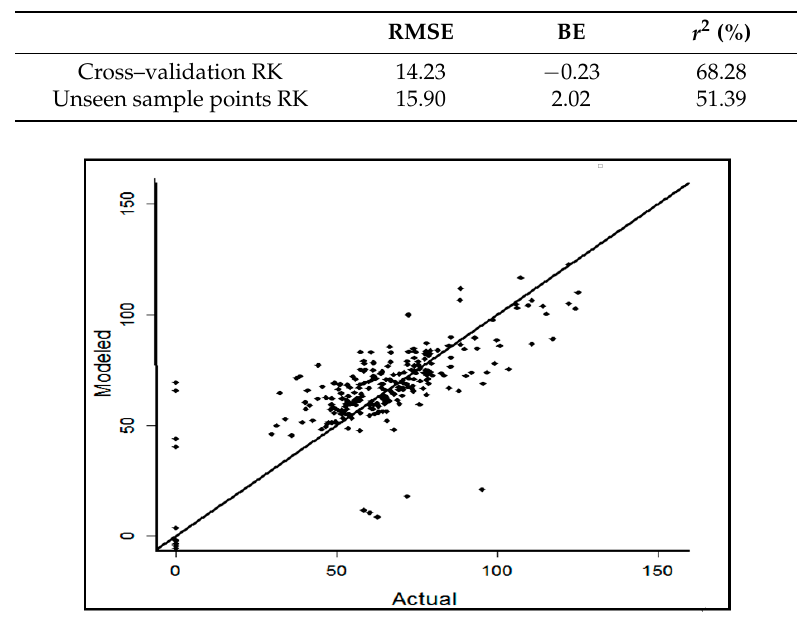
Table 5. Accuracy assessment metrics between the reference and predicted variables using cross-validation and unseen sample points.